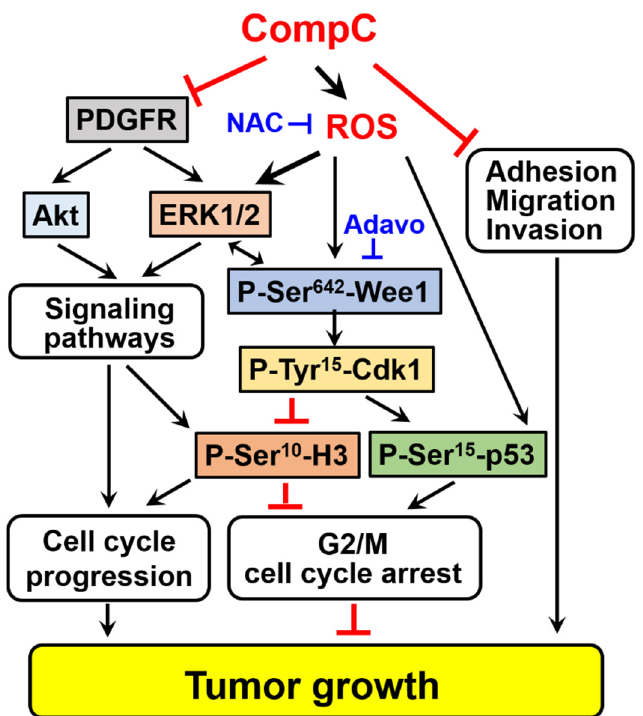
Figure 9. Schematic representation of the effect of CompC on tumor growth in Renca syngeneic mouse model. Arrow ( → ) and truncated line ( ┬ ) indicate activation and inhibition, respectively. Regulatory pathways of cell cycle progression, G2/M cell cycle arrest, adhesion, migration, and invasion diverge into tumor growth in the Renca syngeneic mouse model. The left part of the schematic indicates that CompC suppresses cell cycle progression by inhibiting PDGFR-dependent signaling pathways, including Akt. At the center of the schematic, ROS-dependent ERK1/2 activation also appears to play a role in G2/M cell cycle arrest. The ROS scavenger, N-acetyl cysteine (NAC), interferes with CompC-induced ERK1/2 activation and G2/M cell cycle arrest. ROS may also induce phosphorylation of Wee1 at Ser 642 via ERK1/2 or other signaling pathways. Active Wee1 inactivates Cdk1 by increasing phosphorylation of Cdk1 at Tyr 15 (P-Tyr 15 -Cdk1), which in turn results in the reduction of phosphorylated histone H3 at Ser 10 (P-Ser 10 -H3). CompC-induced inactivation of